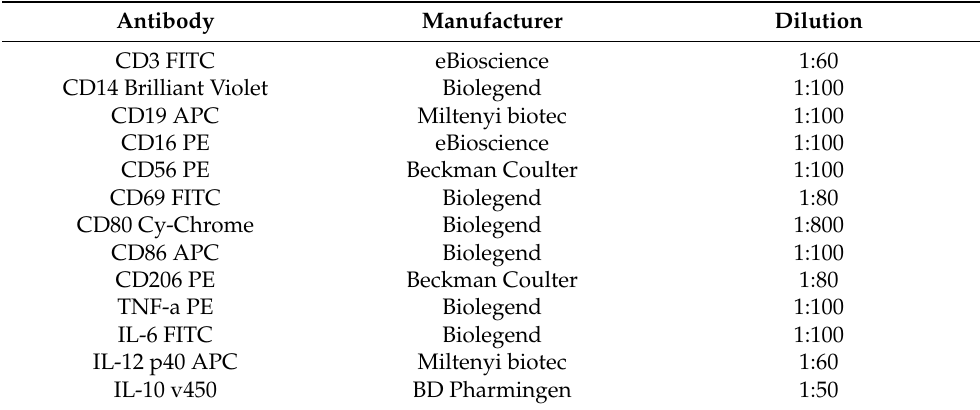
Table 1. Antibodies used for the immunophenotypic characterization of PBMCs and for the evalua- tion of cytokines and inflammatory markers in monocytes/macrophages.